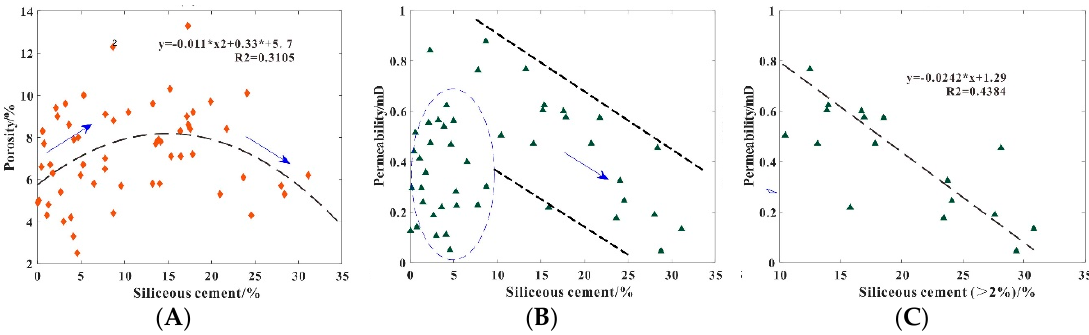
Figure 10. The relation between siliceous cement (%) and reservoir porosity (%) or permeability (mD). ( A ) the relation between siliceous cement (%) and porosity (%); ( B ) the relation between siliceous cement (%) and permeability (mD); ( C ) the relation between siliceous cement (%) except the cements less than 2% and permeability (mD).